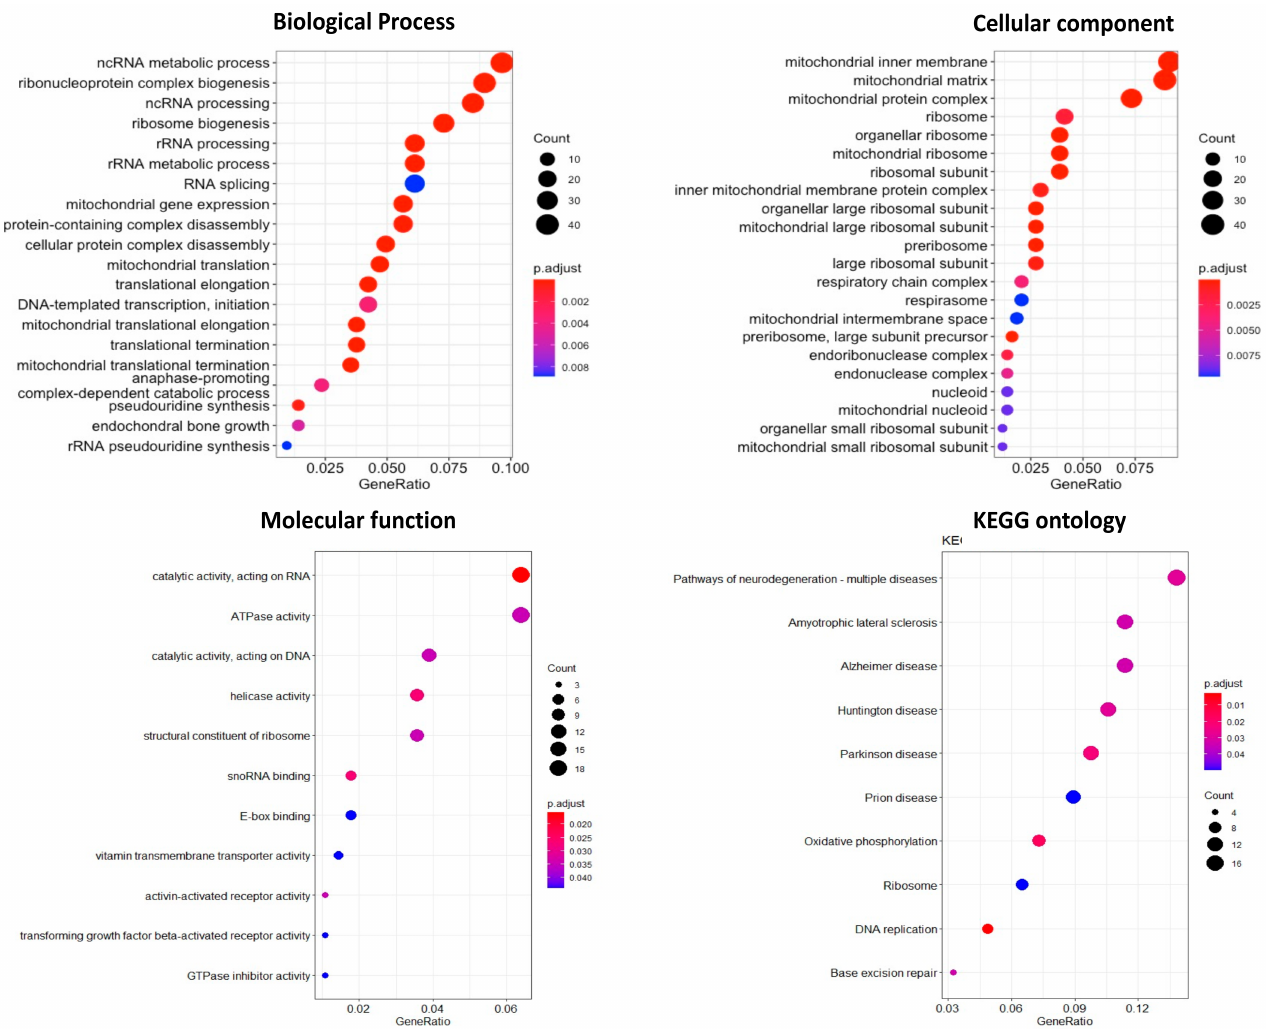
Figure 7. Gene ontology (GO) terms (biological processes, cellular components, molecular functions, and KEGG) with p value of genes. Circle sizes represent the number of genes counted in each function, and bubble colors correspond to p